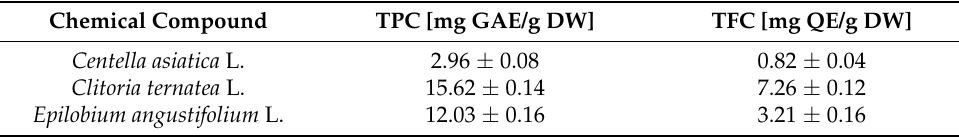
Table 3. Total phenolic and flavonoid content of Centella asiatica L., Clitoria ternatea L., Epilobium angustifolium L. of water-ethanol extracts. Values are the mean of three replicate determinations (n = 3) ± SD. Chemical Compound TPC [mg GAE/g DW] TFC [mg QE/g DW] Centella asiatica L. 2.96 ± 0.08 0.82 ± 0.04 Clitoria ternatea L. 15.62 ± 0.14 7.26 ± 0.12 Epilobium angustifolium L. 12.03 ± 0.16 3.21 ±